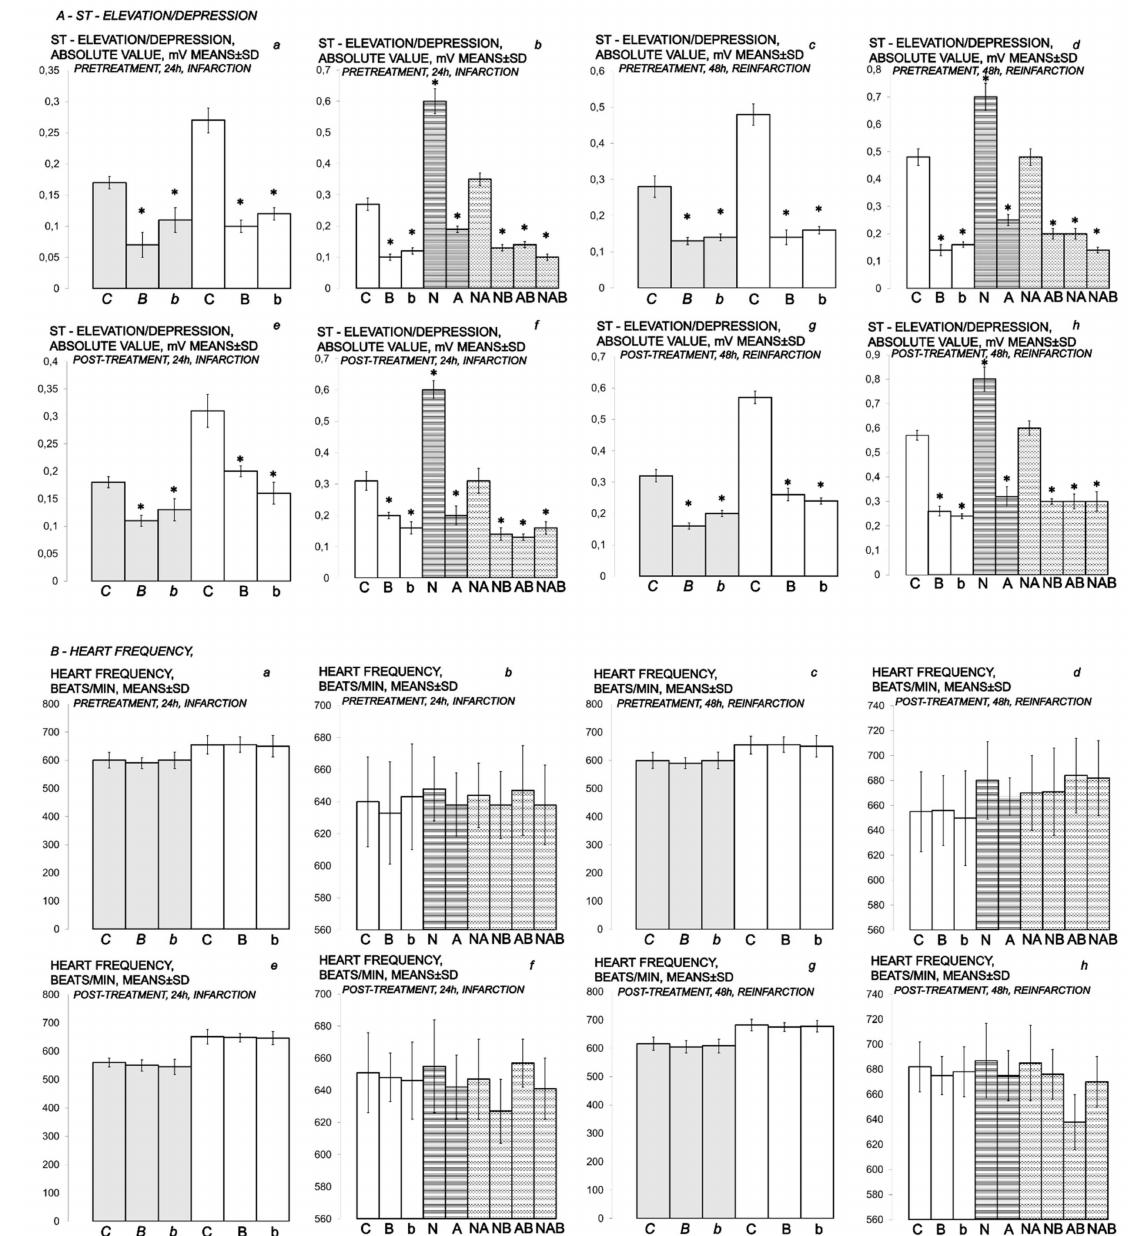
Figure 16. ( A , B ) Myocardial infarction (one isoprenaline challenge) and re-infarction (two isopre- naline subsequent challenges) in isoprenaline-treated rats (75 mg/kg sc (gray bars), 150 mg/kg sc (white bars)). Gross heart lesions presentation; A – ST-ELEVATION/DEPRESSION (mV), B – HEART FREQUENCY (beats/min). Rats treated with the smaller dose of isoprenaline, 75 mg/kg sc (gray bars, italic letters), received medication (BPC 157 (10 ng/kg ( b ), 10 µ g/kg ( B ) i.p. or saline (5 mL/kg i.p. ( C )). Rats treated with the higher dose of isoprenaline, 150 mg/kg sc (white bars, normal let- ters), received medication (BPC 157 (10 ng/kg (b), 10 µ g/kg (B) i.p. or saline (5 mL/kg i.p. (C)) or L-NAME (5 mg/kg i.p. (N)), L-arginine (200 mg/kg i.p. (A)) (horizontal line bars) or these agents in combination (L-NAME + L-arginine (NA), L-NAME + BPC 157 (NB), L-arginine + BPC 157 (AB), L-NAME + L-arginine + BPC 157 (NAB)) (dashed horizontal lines bars). Therapy was given (i) 30 min before isoprenaline ( PRETREATMENT , prophylactic regimen ( a – d )), or, alternatively, (ii) at 5 min after isoprenaline (75 mg/kg s.c. or 150 mg/kg s.c.), at day 1 and at day 2 ( POST-TREATMENT , therapeutic regimen ( e – h )). Ten rats per each experimental group. * p < 0.05 vs. control, at